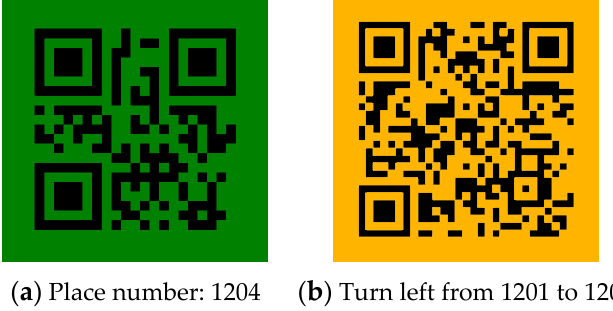
Figure 6. Examples of the generated QR codes and their meaning: ( a ) Location-specific code; ( b ) Directional code.